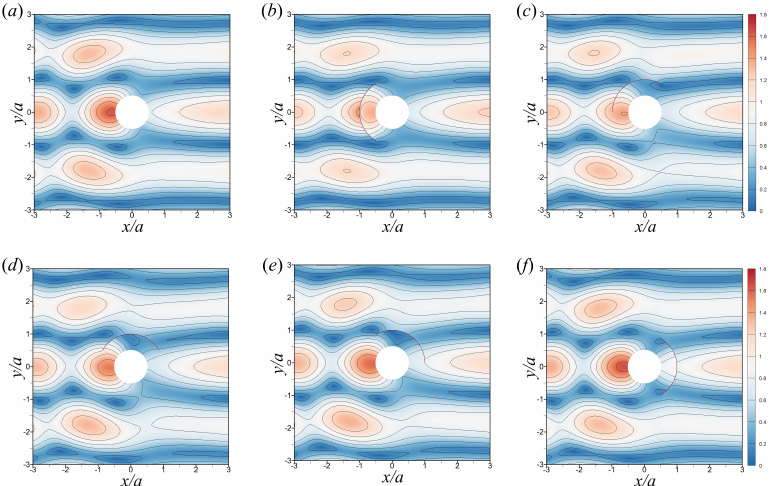
Figure 14. Distribution of the relative wave height for different values of α with ka = 2, a / h = 1, β = π /3, k x / k = 0.5, G = 1, U 0 = 0.4 m/s, and γ = 2 π /3: ( a ) only cylinder; ( b ) α = 2 π /3; ( c ) α = π /3; ( d ) α = π /6; ( e ) α = 0; ( f ) α = − π